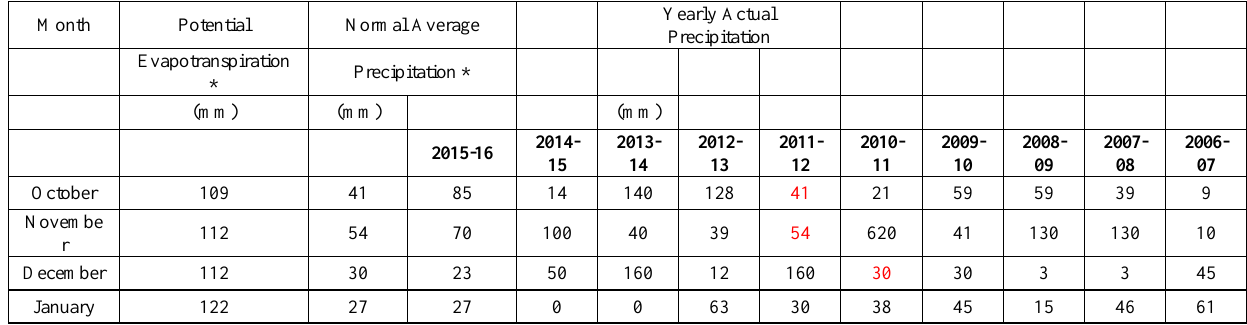
Table 2. Potential Evapotranspiration and Precipitation Near Eldoret (in West